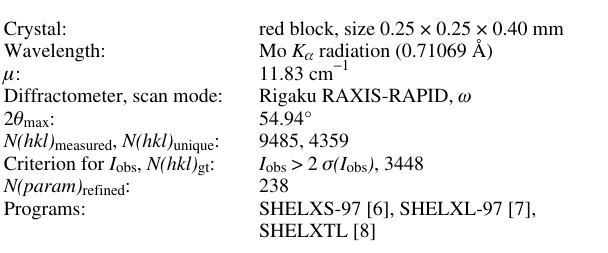
Table 1. Data collection and handling.